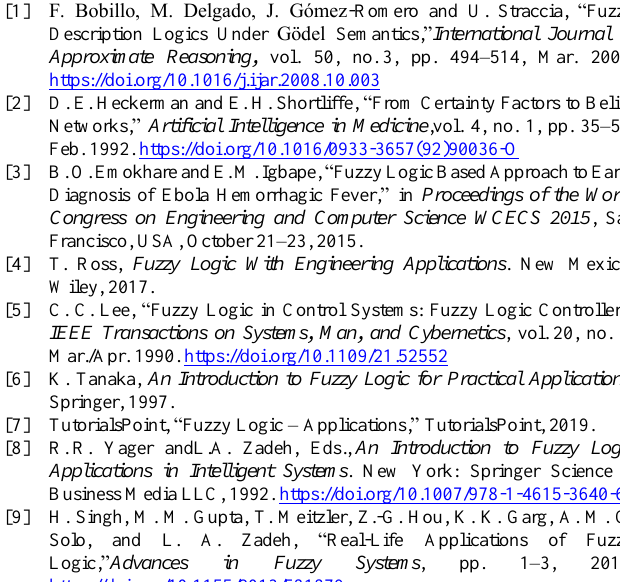
Fig. 6. Generalised model test sample